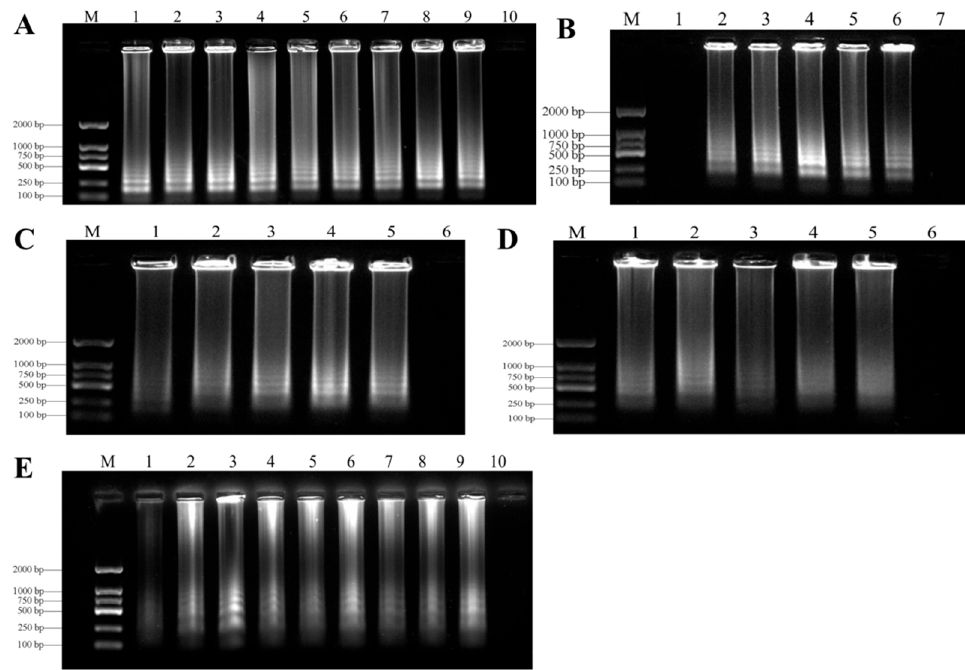
Figure 4. Optimization of LAMP assays. ( A ) = Optimization of LAMP reaction temperature for detection of F. oxysporum . Lane M, Ds 2000 DNA molecular weight marker ladder; Lane 1, 55 °C; Lane 2, 58 °C; Lane 3, 60 °C; Lane 4, 62 °C; Lane 5, 64 °C; Lane 6, 65 °C; Lane 7, 66 °C; Lane 8, 68 °C; Lane 9, 70 °C; Lane 10, negative control. ( B ) = Optimization of LAMP reaction time for detection of F. oxysporum . Lane M, Ds 2000 DNA molecular weight marker ladder; Lane 1, 15 min; Lane 2, 30 min; Lane 3, 45 min; Lane 4, 60 min; Lane 5, 75 min; Lane 6, 90 min; Lane 7, negative control. ( C ) = Optimization of LAMP reaction inner primer (FIP/BIP) concentration for detection of F. oxysporum . Lane M, Ds 2000 DNA molecular weight marker ladder; Lane 1, 0.4 μ M; Lane 2, 0.8 μ M; Lane 3, 1.2 μ M; Lane 4, 1.6 μ M; Lane 5, 2 μ M; Lane 6, negative control. ( D ) = Optimization of LAMP reaction outer primer (F3/B3) concentration for detection of F. oxysporum . Lane M, Ds 2000 DNA molecular weight marker ladder; Lane 1, 0.2 μ M; Lane 2, 0.4 μ M; Lane 3, 0.6 μ M; Lane 4, 0.8 μ M; Lane 5, 1 μ M; Lane 6, negative control. ( E ) = Optimization of LAMP reaction Mg 2+ concentrations for detection of F. oxysporum . Lane M, Ds 2000 DNA molecular weight marker ladder; Lane 1, 2 mM; Lane 2, 3 mM; Lane 3, 4 mM; Lane 4, 5 mM; Lane 5, 6 mM; Lane 6, 7 mM; Lane 7, 8 mM; Lane 8, 9 mM; Lane 9, 10 mM; Lane 10, negative control. 3.3. Specificity of LAMP Assays LAMP specificity was determined with genome DNA from F. oxysporum and other pathogens through direct visual observation after adding SYBR Green I stain (Table 1). After the reaction, positive samples of color turned green but the color of negative samples remained orange. LAMP primers of F. oxysporum based on TEF-1 α amplification yielded positive reactions when testing for DNA, while the DNA from other pathogens were used as negative controls (Figures 5 and S2).